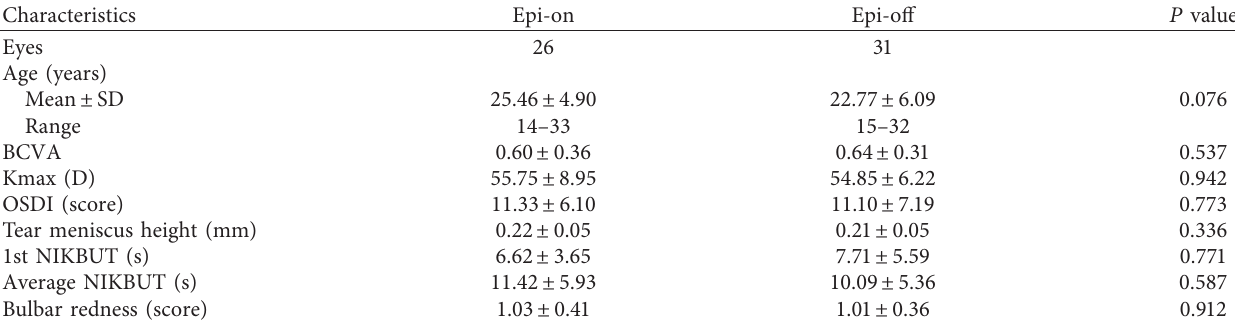
Table 4: Demographic characteristics and baseline evaluation.